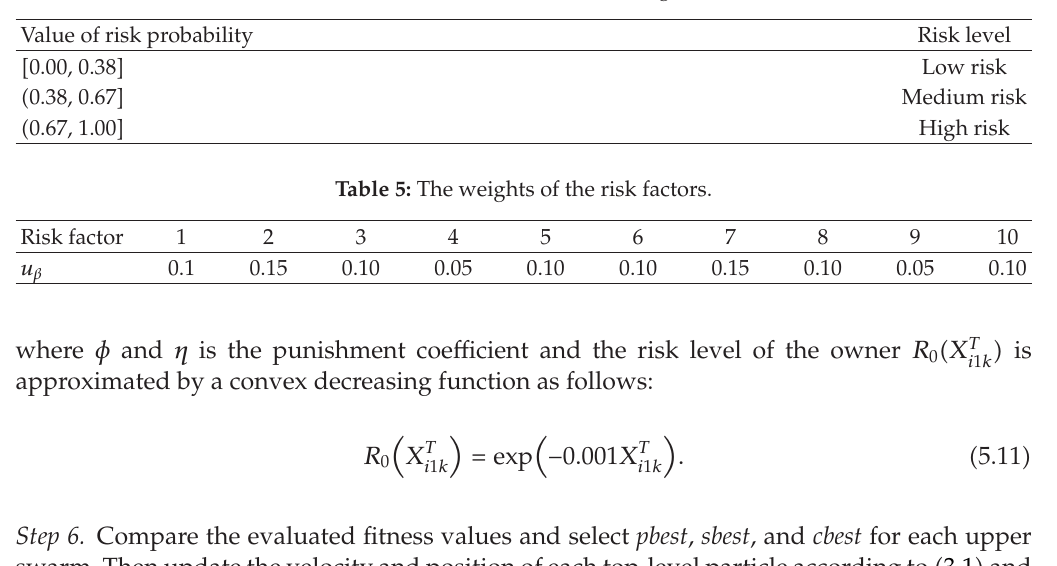
Table 4: Criterion of risk rating.